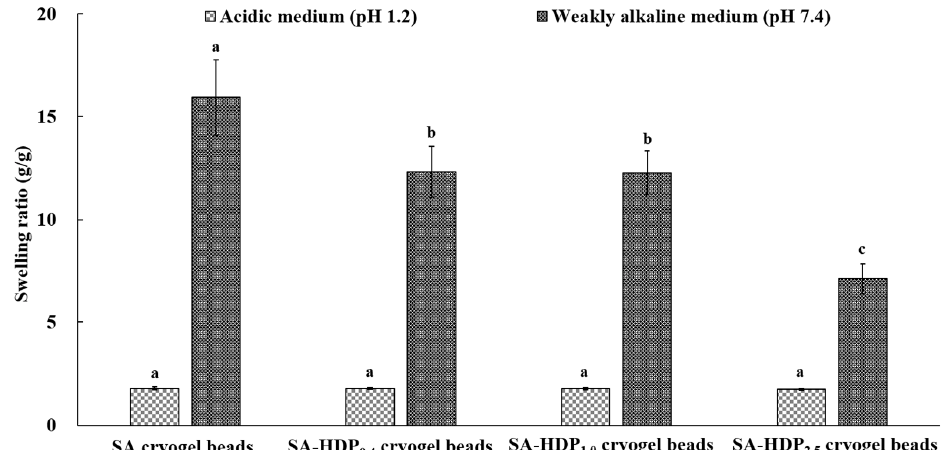
Figure 5. Swelling ratio of sodium alginate (SA)-based cryogel beads filled with different concentrations of hydroxypropyl distarch phosphate (HDP) under different pH conditions. SA cryogel beads, SA-HDP 0.4 cryogel beads, SA-HDP 1.0 cryogel beads, and SA-HDP 2.5 cryogel beads represent cryogel beads filled with different concentrations of HDP (0, 0.4, 1.0 and 2.5%, respectively). Values with different letters within the same column differ significantly ( p < 0.05).